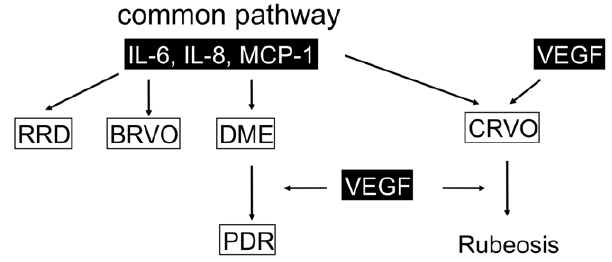
Figure 6. Possible contribution of major four factors: IL-6, IL-8, MCP-1 and VEGF in vitreoretinal diseases. A scheme illustrates the relations between the different mediators in samples from the different vitreoretinal diseases: IL-6, IL-8, and MCP-1 in the vitreous cavity can increase vascular permeability that causes DME, but an additional retinal ischemia led to increased VEGF production that play an important role in the progression of DME to PDR. At the same time, high VEGF levels may be initially produced by the sudden profound retinal injury, and then induced major three factors, frequently resulted in rubeosis